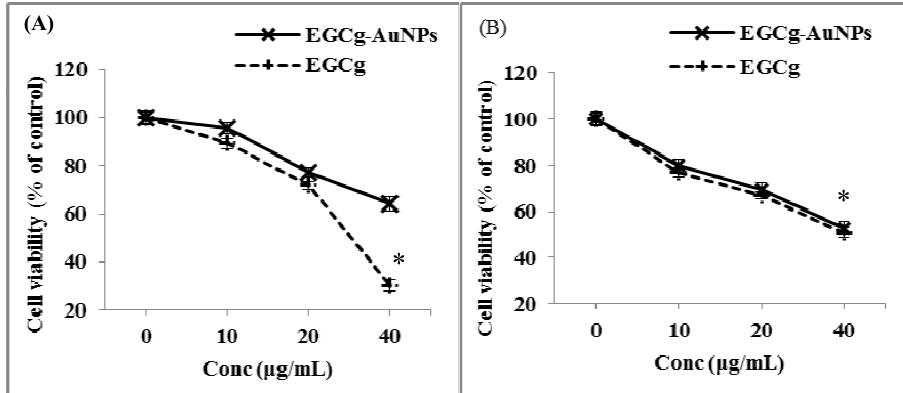
Figure 6. Effect of EGCg-AuNPs and free EGCg on endothelial and smooth muscles cells viability; (means ± SE; n = 3), cells treated for 24 h. ( A ) HUVECs (Human umbilical vein endothelial cells): * p < 0.05 vs. EGCg-AuNPs at same concentration (40 μ g/mL); ( B ) HCASMCs (Human coronary artery smooth muscle cells): * p > 0.05 vs. EGCg-AuNPs at same concentration (40 μ g/mL).